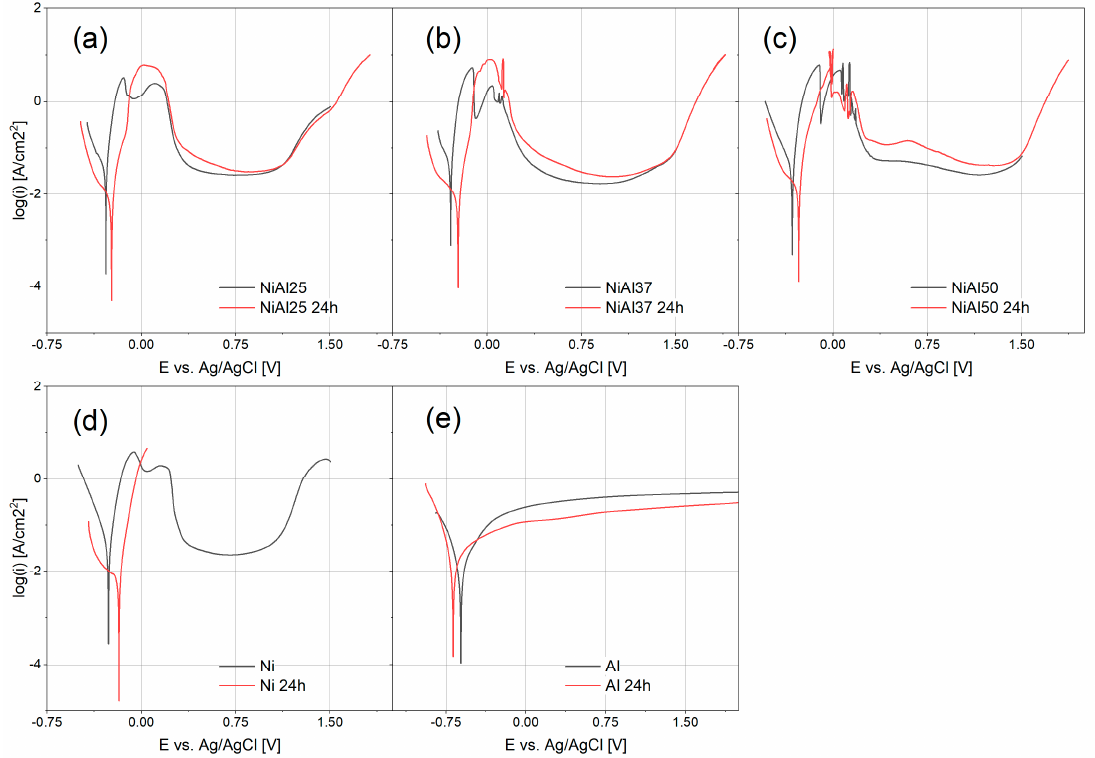
Figure 7. Polarization curves in 0.1 M H 2 SO 4 for: ( a ) NiAl25, ( b ) NiAl37, ( c ) NiAl50, ( d ) Ni and ( e ) Al samples.